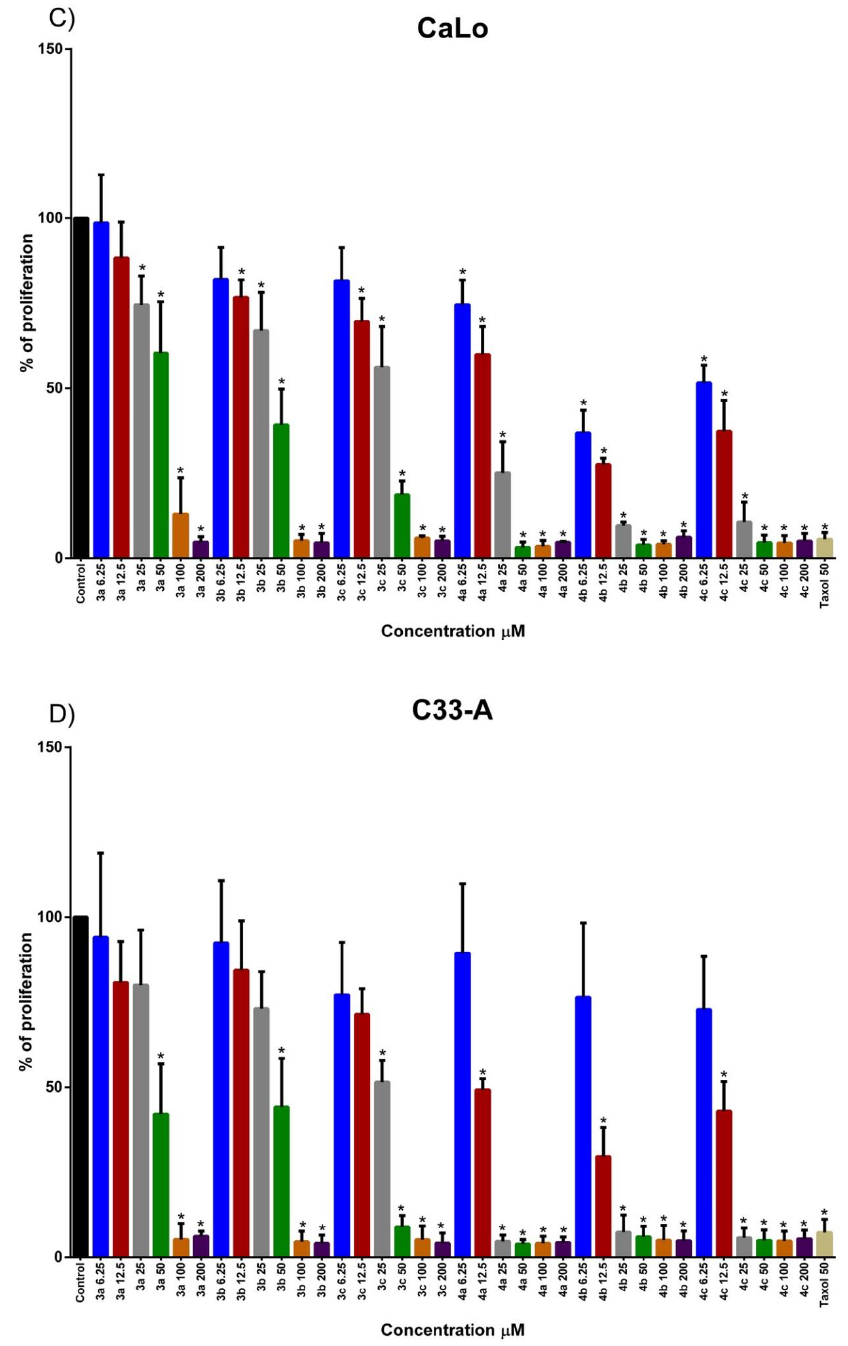
Figure 4. Proliferation e ff ect of Naphthoquinone amino acid derivatives was evaluated in HPV positive cancer cell lines derived from cervix and a non-tumorigenic HPV negative cell line. ( A ) HaCaT HPV negative cell line cells were treated with 6.25, 12.5, 25, 50, 100 and 200 µ M of naphthoquinone amino acid derivatives to assay proliferation rate at 72 h post-treatment. ( B ) SiHa HPV 16 positive cancer cells were treated with 6.25, 12.5, 25, 50, 100 and 200 µ M of naphthoquinone amino acid derivatives to assay proliferation rate at 72 h post-treatment. ( C ) CaLo HPV 18 positive cancer cells were treated with 6.25, 12.5, 25, 50, 100 and 200 µ M of naphthoquinone amino acid derivatives to assay proliferation rate at 72 h post-treatment. ( D ) C33-A HPV negative cancer cells were treated with 6.25, 12.5, 25, 50, 100 and 200 µ M of naphthoquinone amino acid derivatives to assay proliferation rate at 72 h post-treatment. Cells treated with 0.1% of DMSO were used as Control. * represents statistically significant p < 0.05